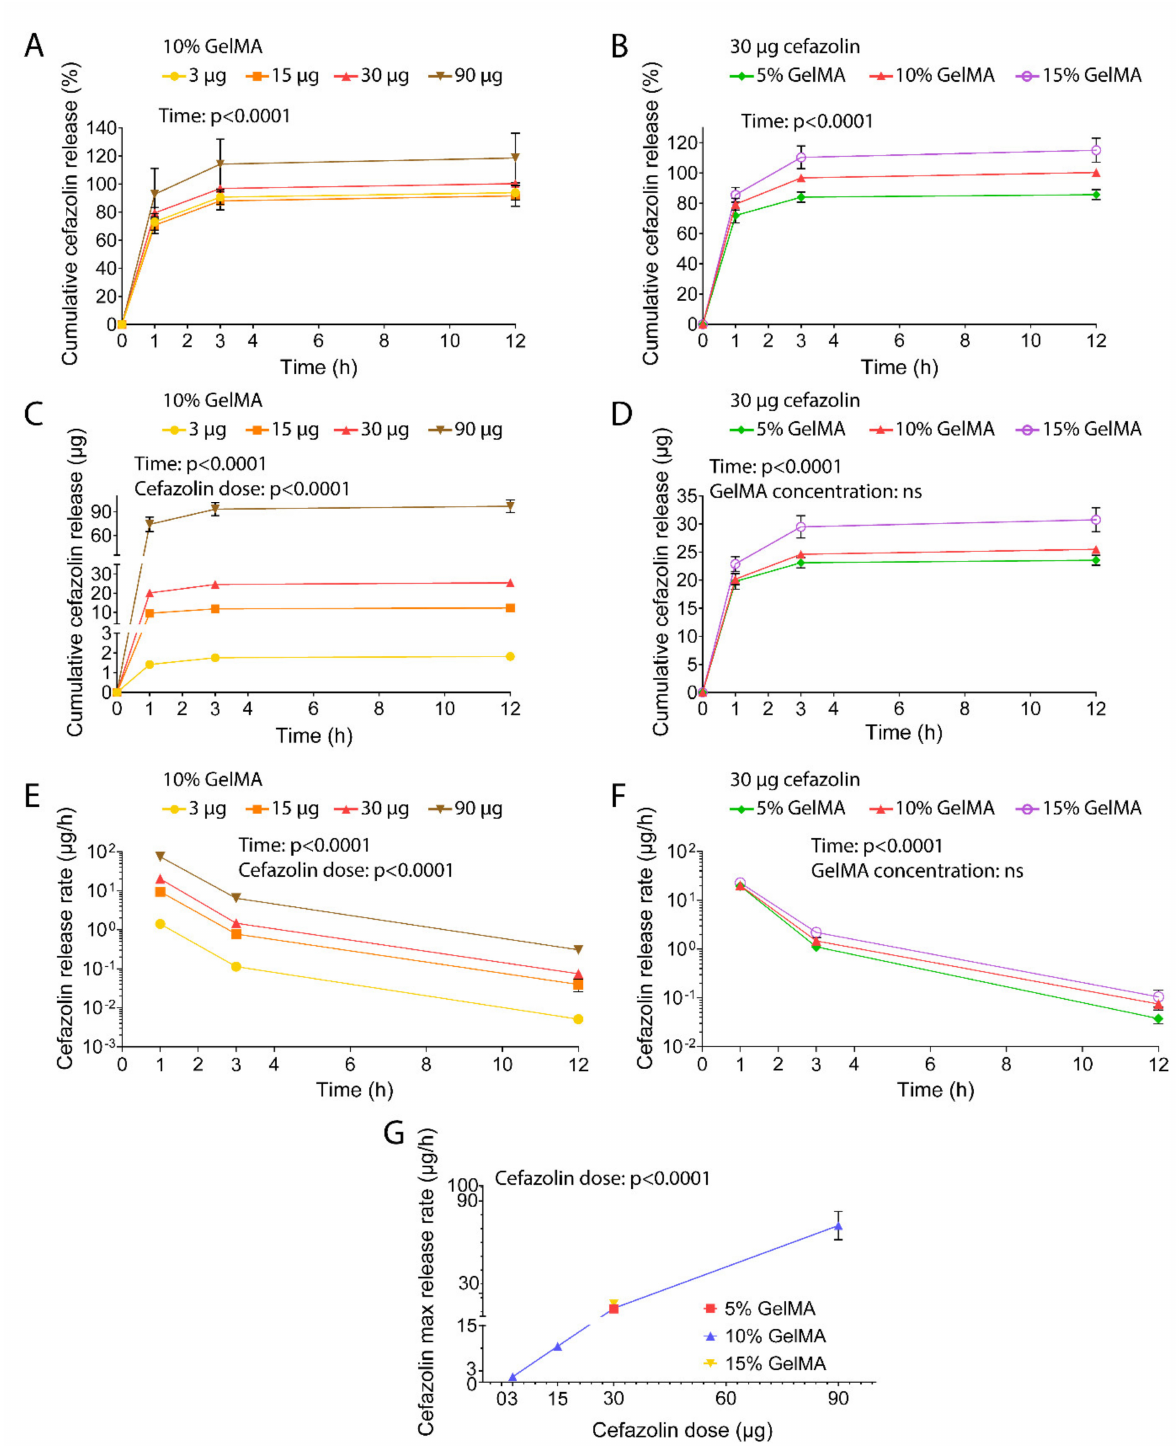
Figure 2. In vitro release of cefazolin in phosphate-buffered saline at pH 7.4, under 75 rpm agitation at 37 ◦ C. ( A ) Cefazolin cumulative release for 3 µ g, 15 µ g, 30 µ g, and 90 µ g from 10% GelMA expressed as percentage of the encapsulation efficiency. ( B ) Cefazolin cumulative release for 30 µ g from 5%, 10%, and 15% GelMA expressed as percentage of the encapsulation efficiency. ( C ) Cefazolin cumulative release for 3 µ g, 15 µ g, 30 µ g, and 90 µ g from 10% GelMA expressed in µ g. ( D ) Cefazolin cumulative release for 30 µ g from 5%, 10%, and 15% GelMA expressed in µ g. ( E ) Cefazolin release rate per hour for 3 µ g, 15 µ g, 30 µ g, and 90 µ g from 10% GelMA expressed in µ g/hour. ( F ) Cefazolin release rate per hour for 30 µ g from 5%, 10%, and 15% GelMA expressed in µ g/h. ( G ) Cefazolin maximum release rate at 1 h expressed in µ g/h. Data are shown as mean ± standard deviation. The experiment was performed once with n = 6 technical